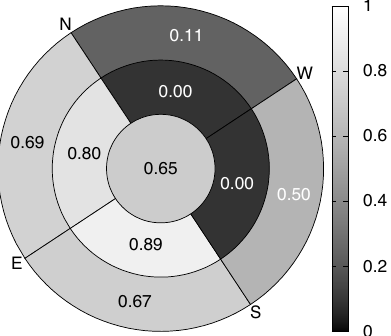
Figure 8: Result of scoring of Fig7. The number in each area are ratios in the area. When the ratio is high, it indi- cates clear viewing and it show as a light color. When the ratio is low, each area indicates cloudy viewing and it is a dark color.